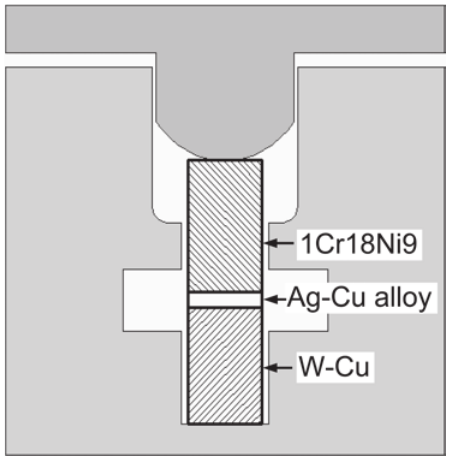
Fig. 2: Sketch of clamp used in the brazing